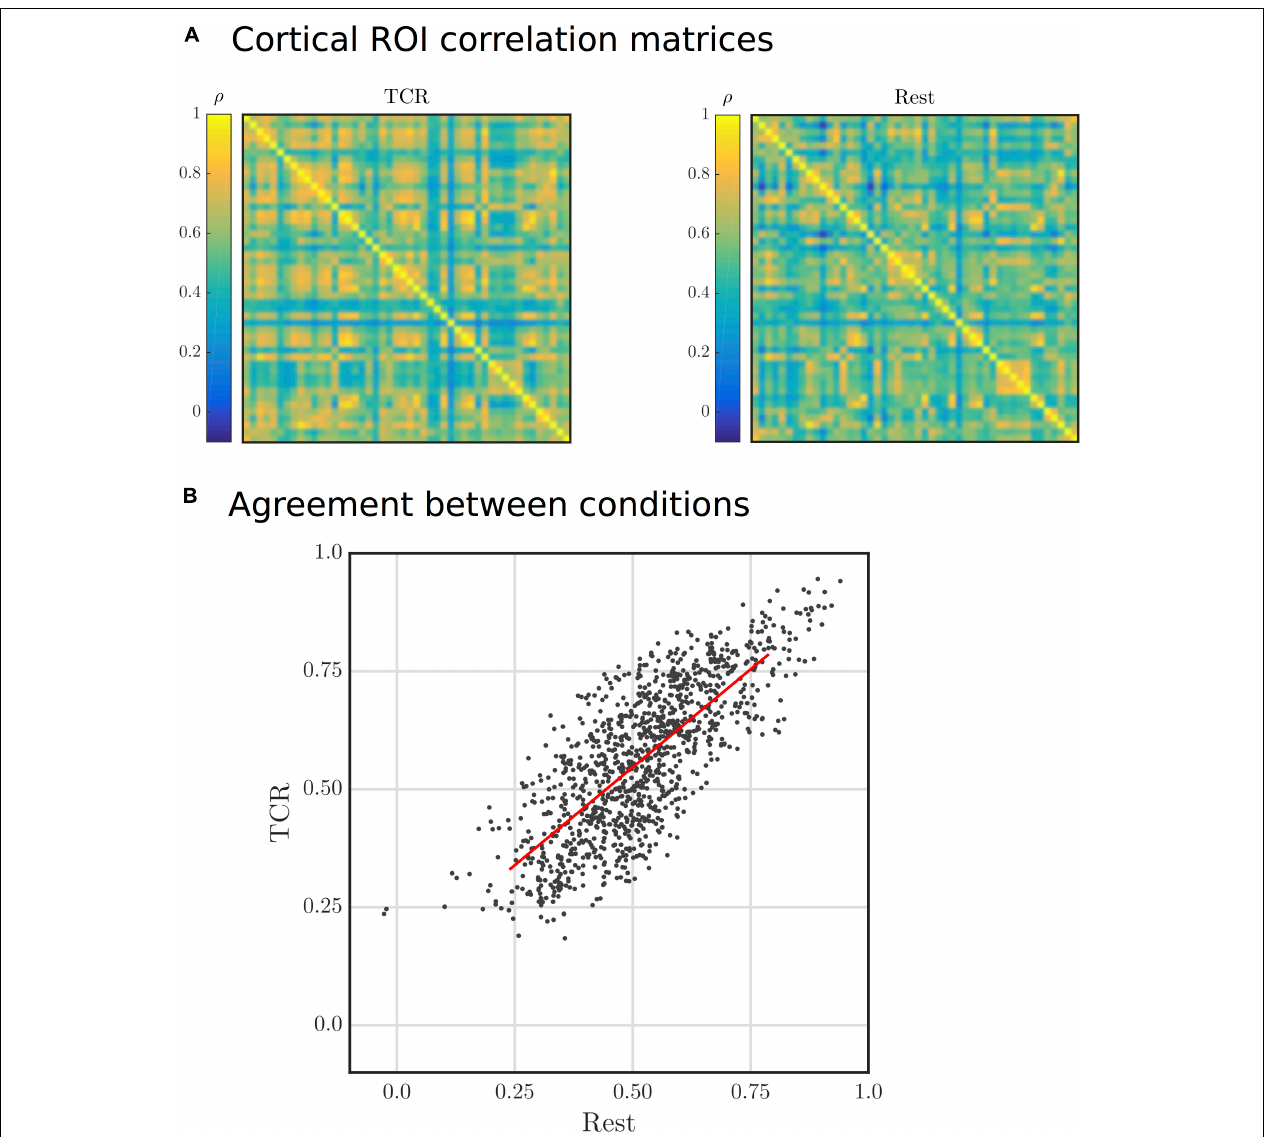
FIGURE 7 | (A) Group average Harvard-Oxford cortical ROI correlation matrices for Rest and TCR conditions. The order of the ROIs in the matrices is not particularly important in this physiological context, but can found by referring to the Harvard-Oxford Cortical Atlas. (B) Scatter plot of group average Harvard-Oxford cortical ROI correlations between the Rest and TCR condition. Each point represents a correlation between two cortical ROIs for each